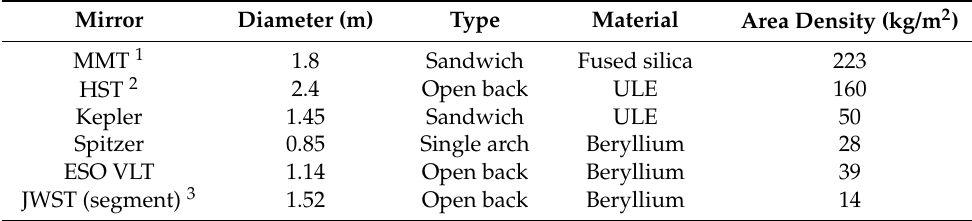
Table 1. Area density for representative mirrors.